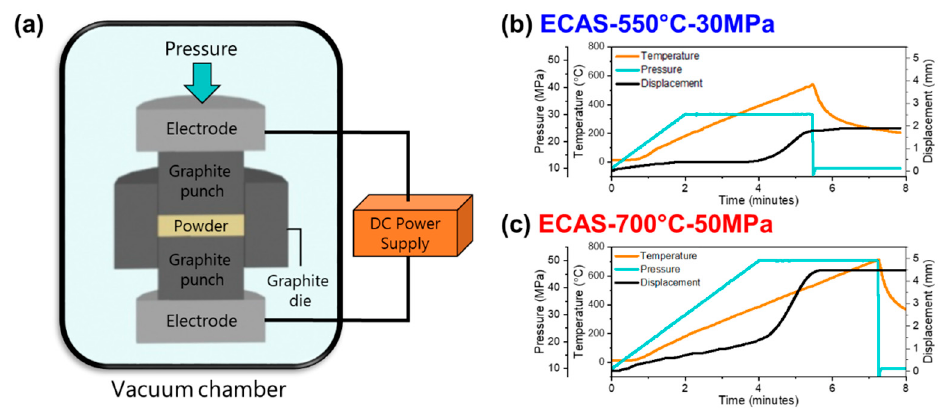
Figure 2. ( a ) Schematic of a spark plasma sintering system. Temperature, pressure, and displacement plots for the sintered JSC-1A samples: ( b ) ECAS-550 °C-30 MPa and ( c ) ECAS-700 °C-50 MPa.